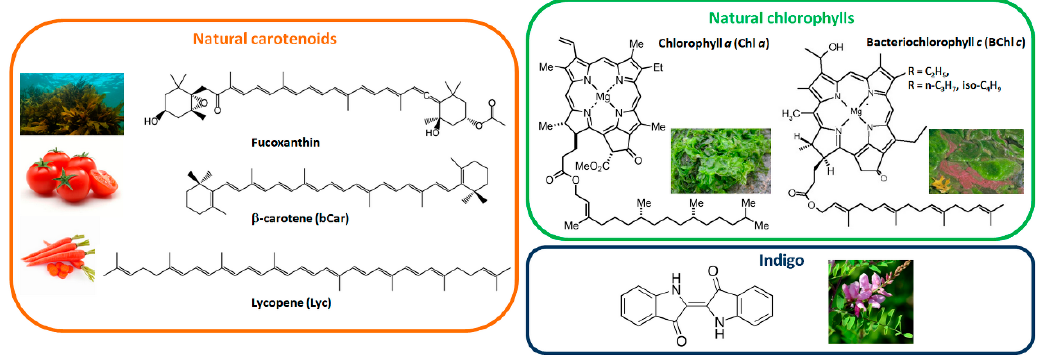
Figure 2. Molecular structures of natural dyes reviewed in this study along with the images of the typical plants, fruits or bacteria they can be extracted from.